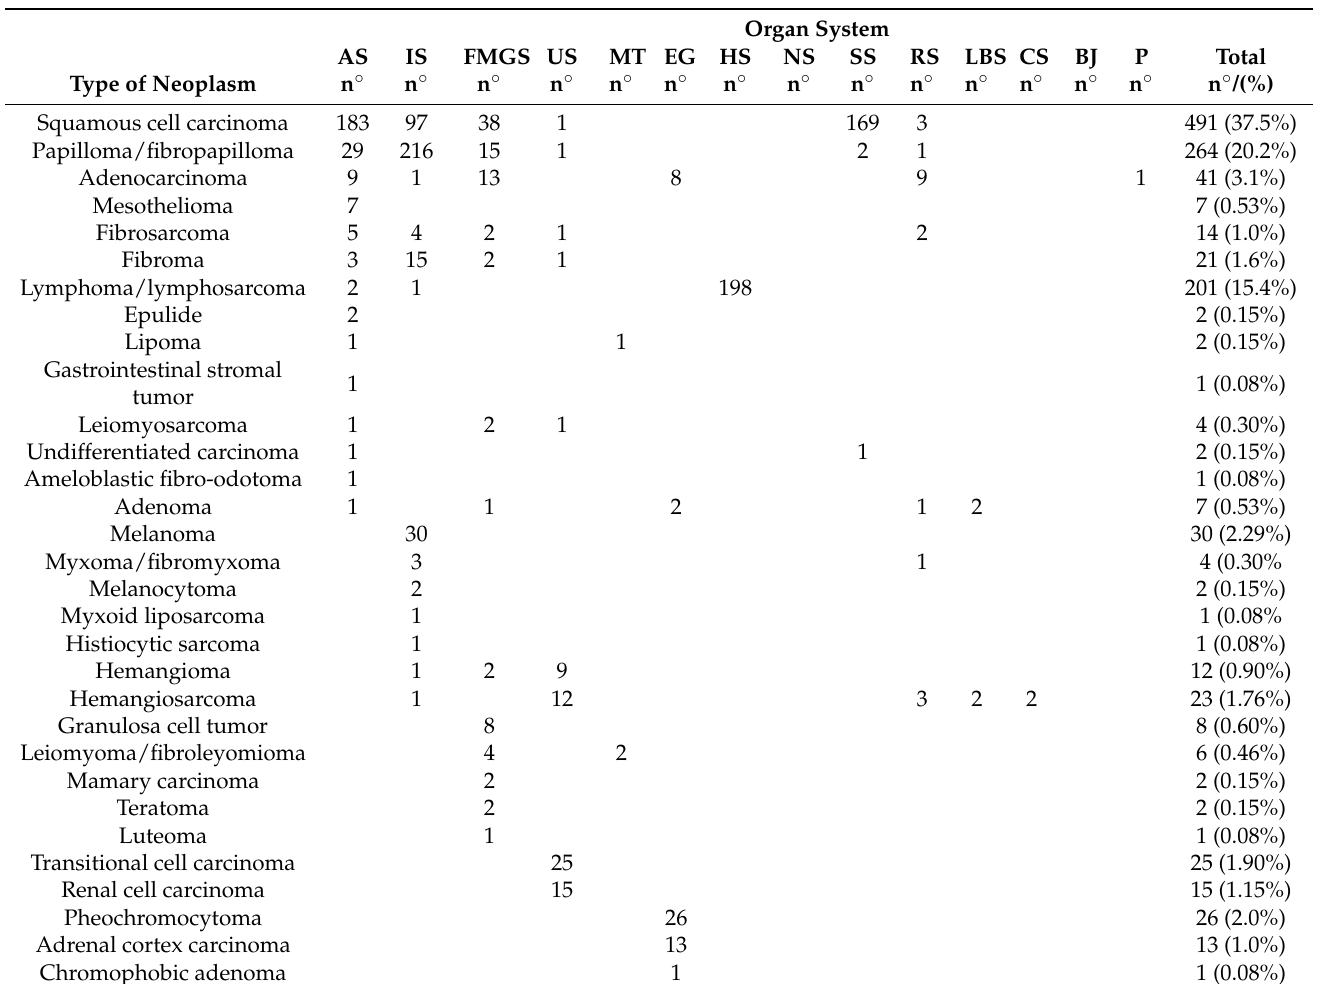
Table 4. Distribution of neoplasms in cattle according to the organ